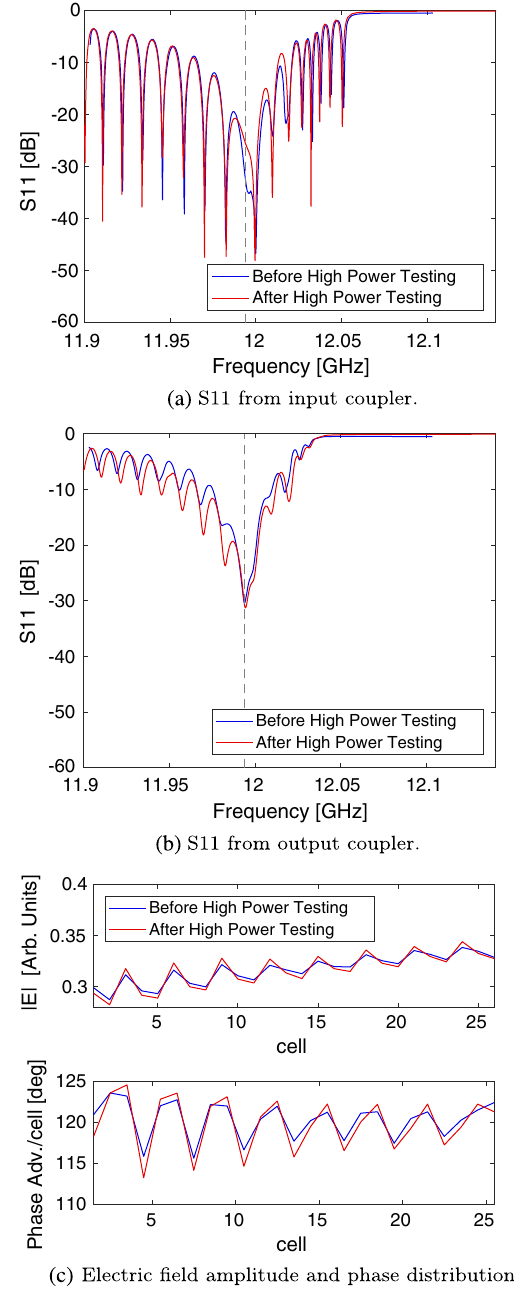
FIG. 15. A comparison of the rf tests before and after high power testing.